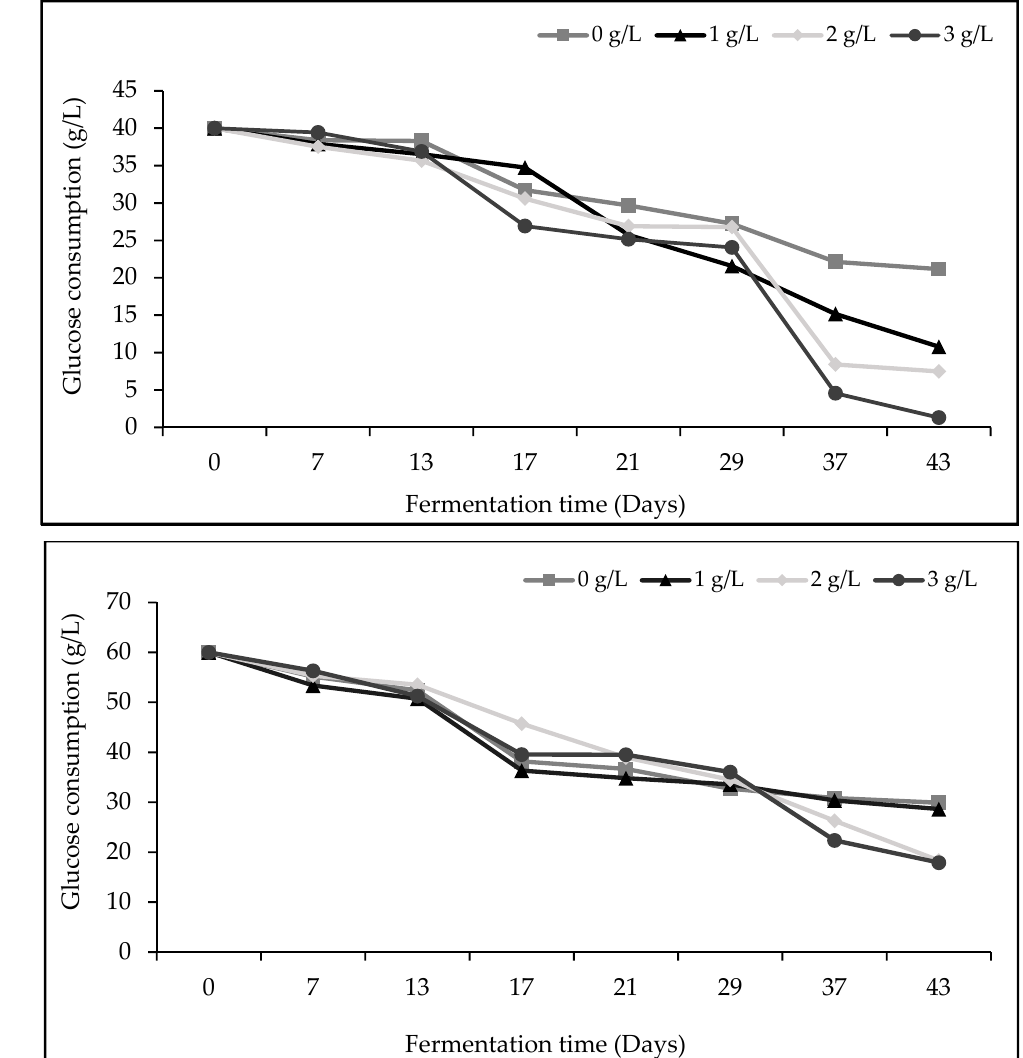
Figure 2. Kinetics of glucose consumption (g/L) during the cultivation of P. pulmonarius in liquid cultures with OMWs containing 0, 1, 2 and 3 g/L phenolic compounds and initial concertation glucose ( a ) 40 g/L (S0-G40, S1-G40, S2-G40, S3-G40) and ( b ) 60 g/L (S0-G60, S1-G60, S2-G60,